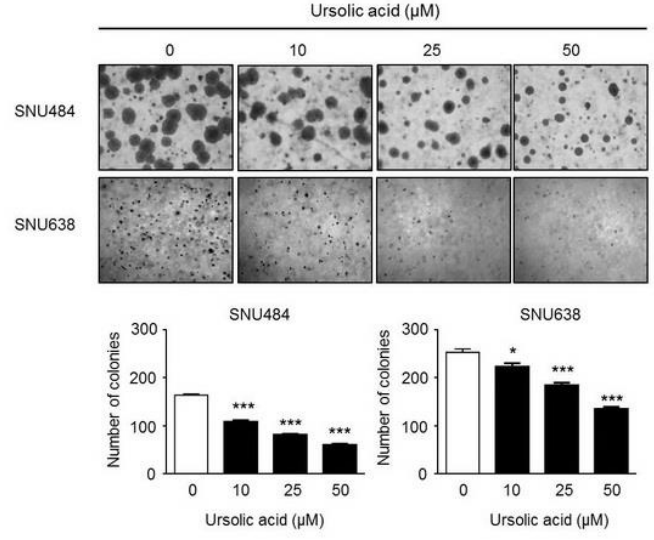
Figure 2. Soft agar colony formation assays. UA significantly the inhibited colony formation of SNU484 and SNU638 cells in a dose- dependent manner (0, 10, 25, 50 μM). Multiplication, 100X. Data represent the mean ± SE of three independent experiments. * p < 0.05 and *** p < 0.001 compared to the